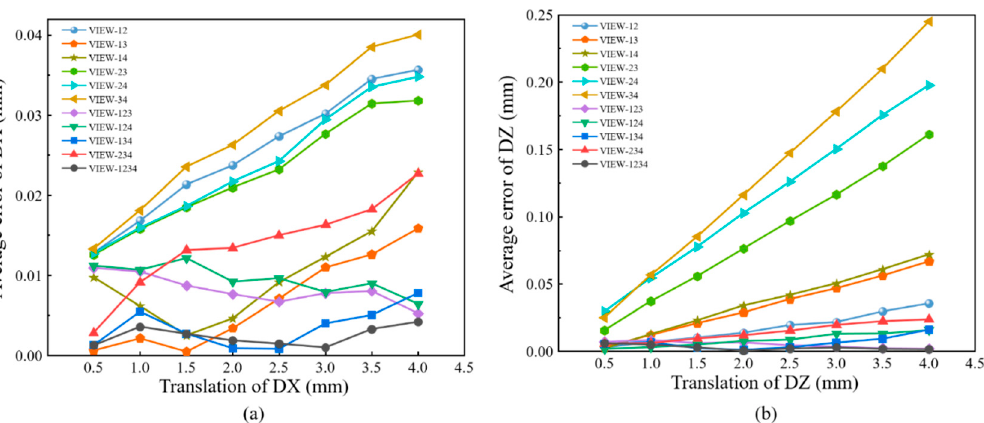
Figure 12. Results and comparisons in the rigid body translation experiment: ( a ) absolute error of in-plane displacement; ( b ) absolute error of out-of-plane displacement.